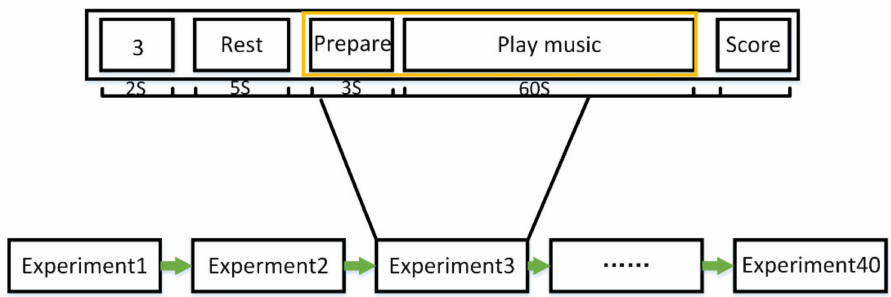
Figure 1. The experimental paradigm for the DEAP dataset. For each experiment, the current experiment number is displayed for 3 s, followed by a 5 s break after the music is played for 63 s, and finally the self-assessment